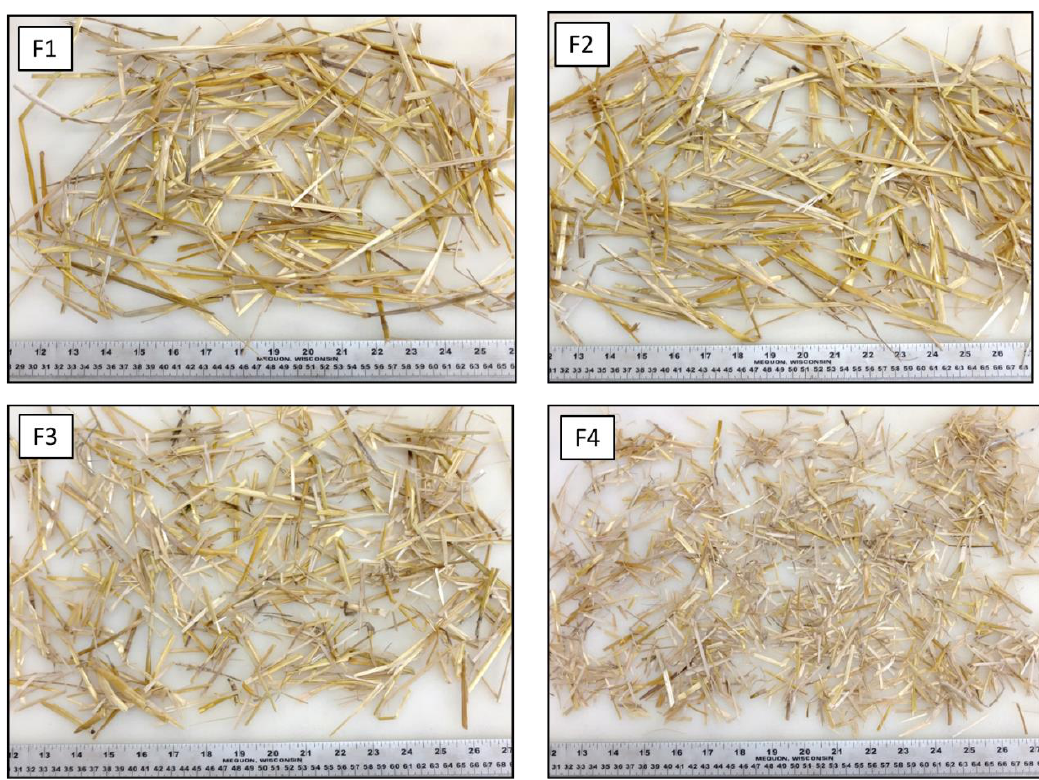
Figure 6. Wheat residue collected in fractions F1 through F4 (see Figure 1).